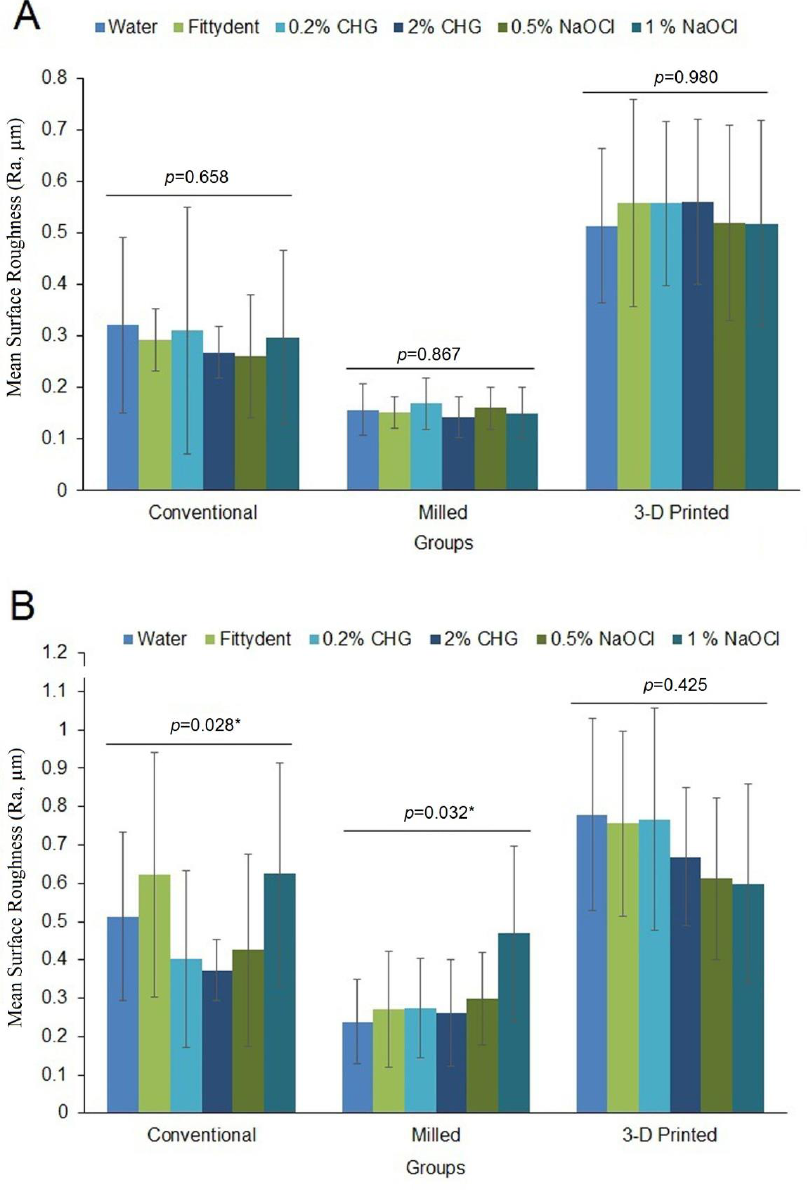
Figure 2. Mean Surface Roughness (Ra) of the material groups. ( A ) Pre-treatment, ( B ) Post-treatment either in distilled water or denture cleanser solutions. Bars indicate SD. * indicate significant difference within the materials (conventional and milled) after surface treatment with denture cleansers .